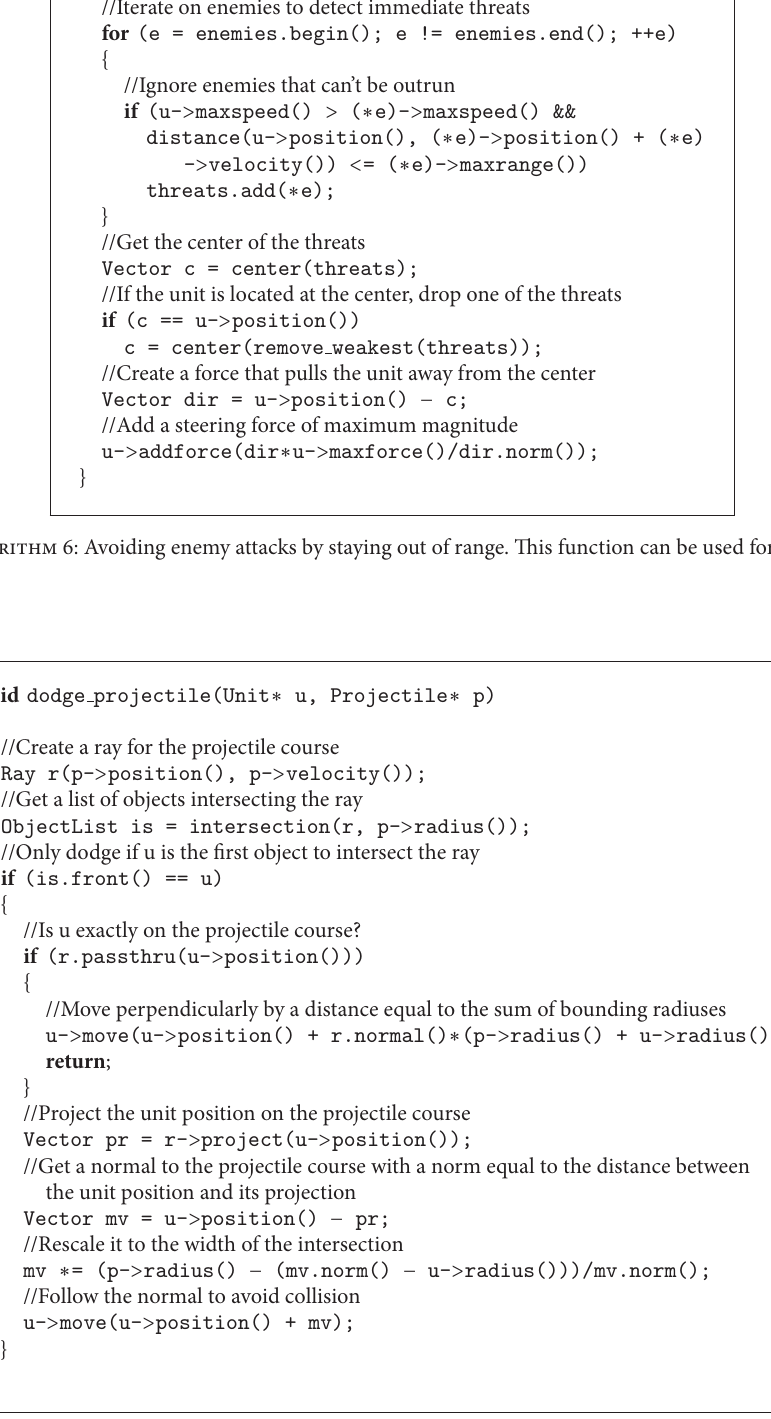
Algorithm 7: Dodging a straight line projectile. This function assumes that the projectile is not